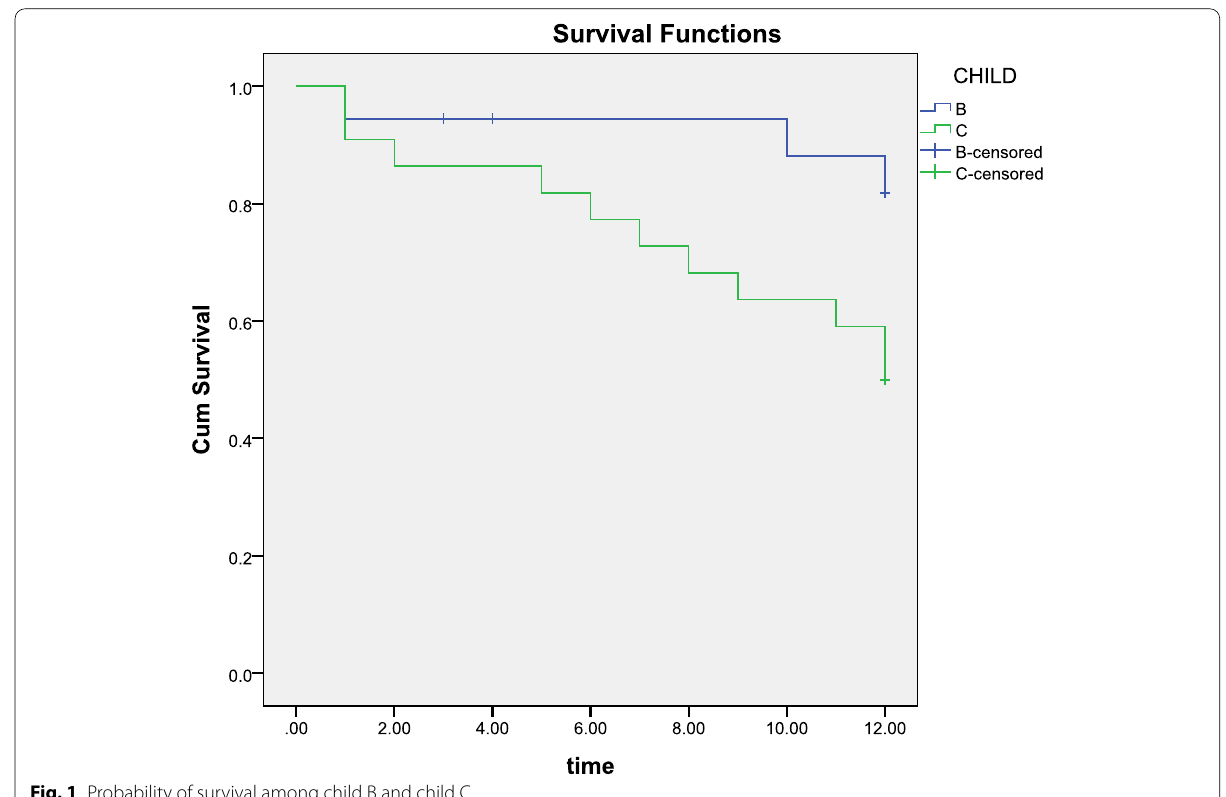
Fig. 1 Probability of survival among child B and child